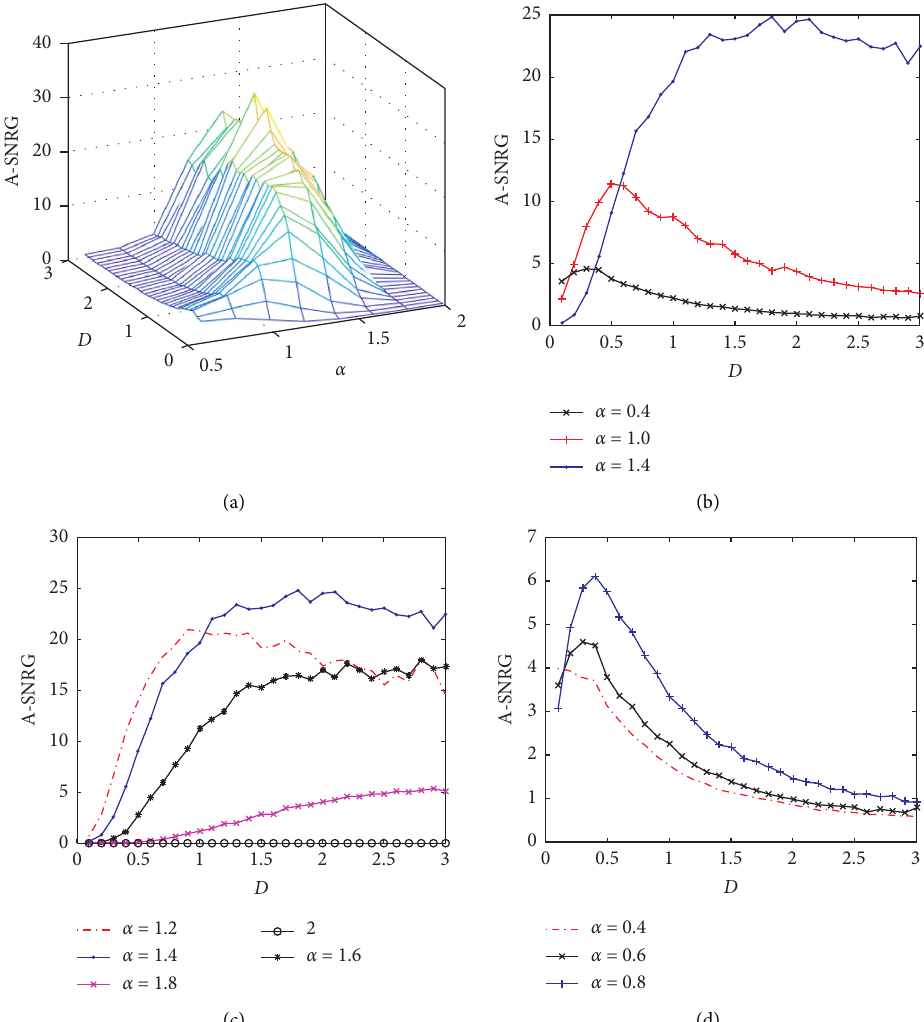
Figure 6: (a) A-SNRG of SR with asymmetric depth of potential well as a function of noise intensive D and asymmetric factor with different values of α . (b) A-SNRG of SR with asymmetric depth of potential well as a function of noise intensive D for different values of the asymmetric factor with α . (c) α > 1 and (d) α <